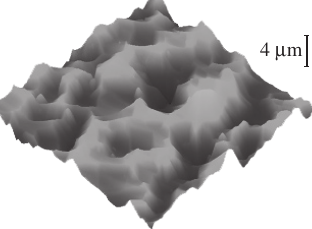
Figure 1. AFM image (contact mode, 50 x 50 µ m 2 ) of rough surface of Si showing the box-like holes.